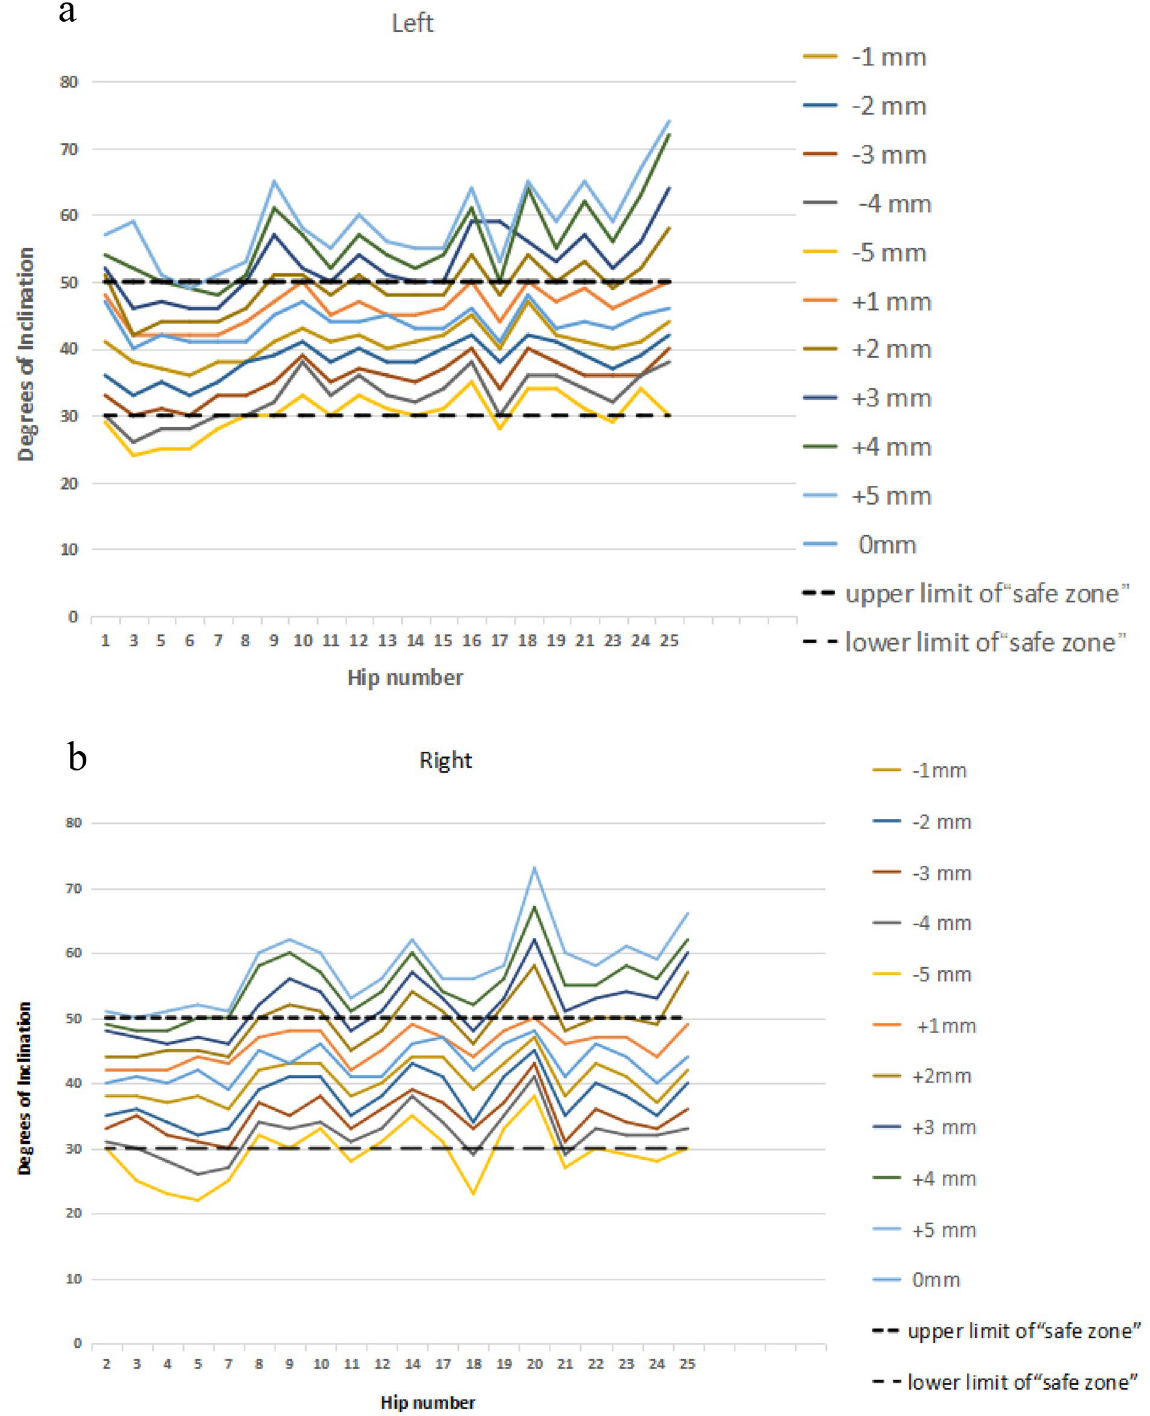
Figure 6. Cup’s inclination of 11 different cup positions in relation to Lewinnek’s safe zone for inclination (( a ) left hips; ( b ) right